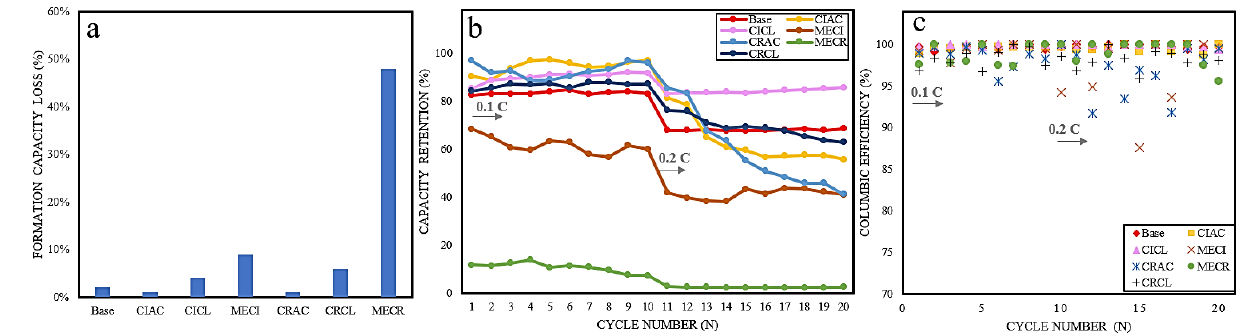
Figure 5. Comparing the cycle performance of the modified electrolytes with the base electrolyte in a half-cell configuration. The initial capacity loss during the SEI formation step ( a ), the capacity retention of the cells after the interphase formation ( b ), and the relevant columbic efficiency ( c ) are shown.